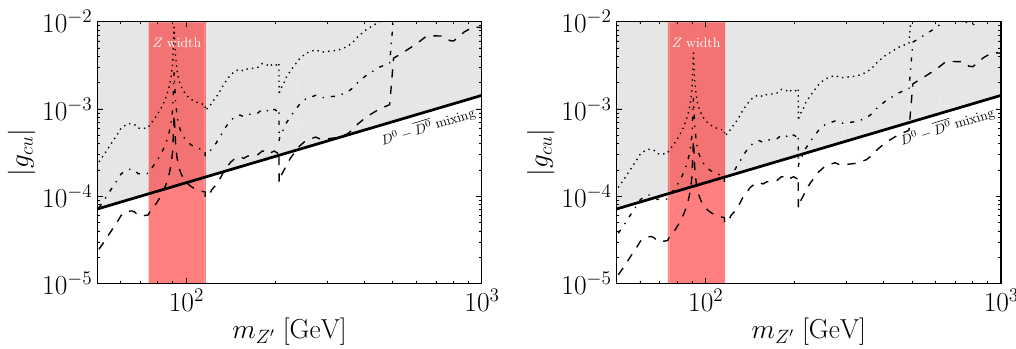
Figure 1 . The values of g cu as a function of m Z | | 6 . 0 10 − 4 (right panel). The dotted line corresponds to ∆ NP = − × ˜ A s = 1 / 3 and the dashed line corresponds to line stands for BSM | | 0 D oscillations. We have fixed g ss to the maximum value allowed by collider ruled out by D 0 − experiments; see the text. Within the red region, the dominant constraint comes from the Z width, while outside this region the dijet searches are more